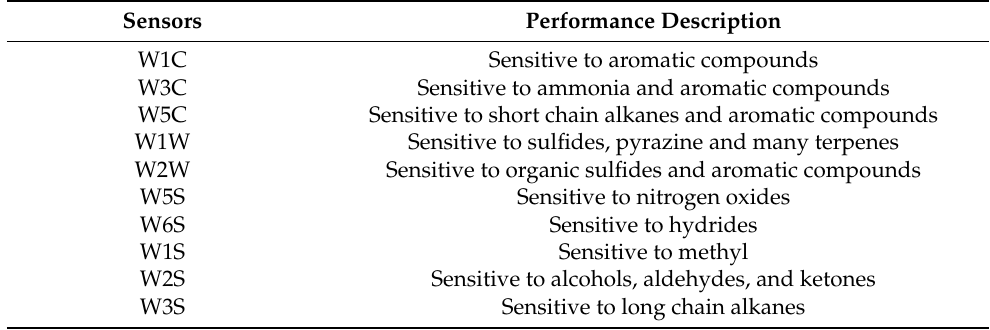
Table 1. Performance description of electronic nose sensors.